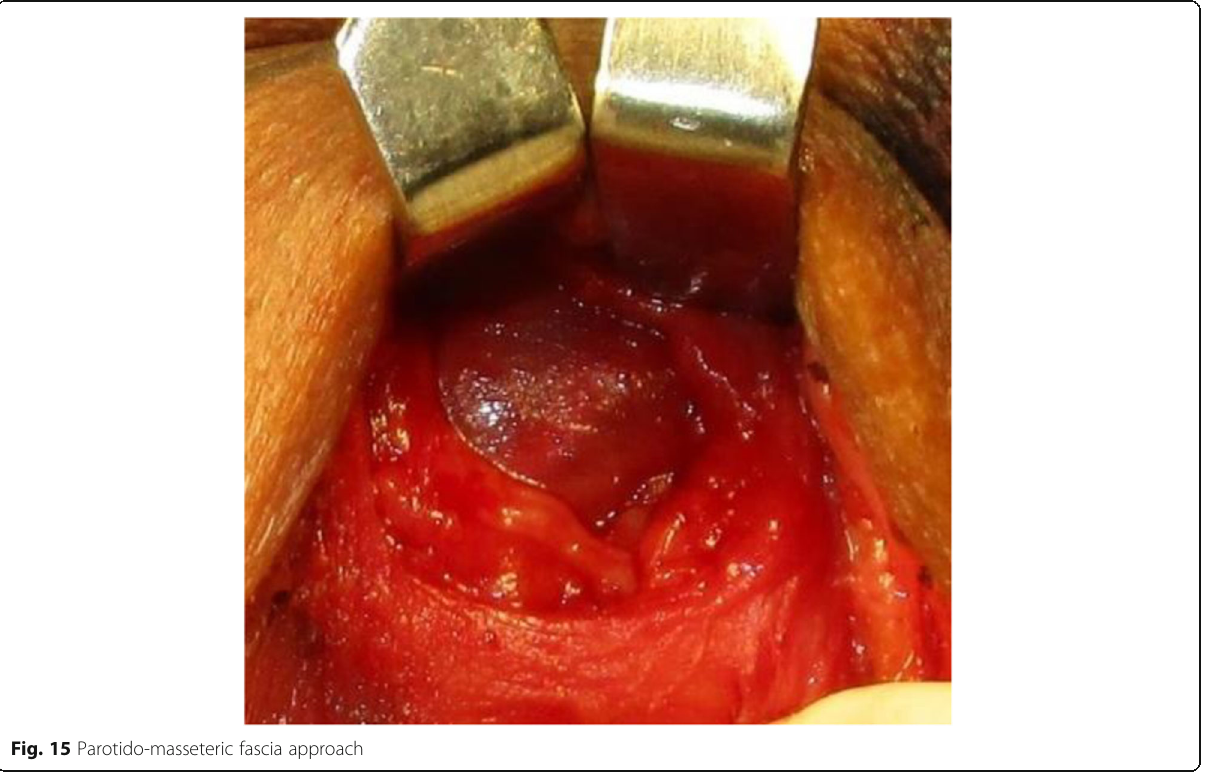
Fig. 15 Parotido-masseteric fascia approach